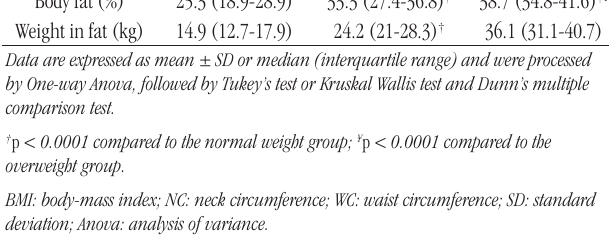
taBLE 2 − Biochemical characteristics related to insulin resistance Biochemical characteristics